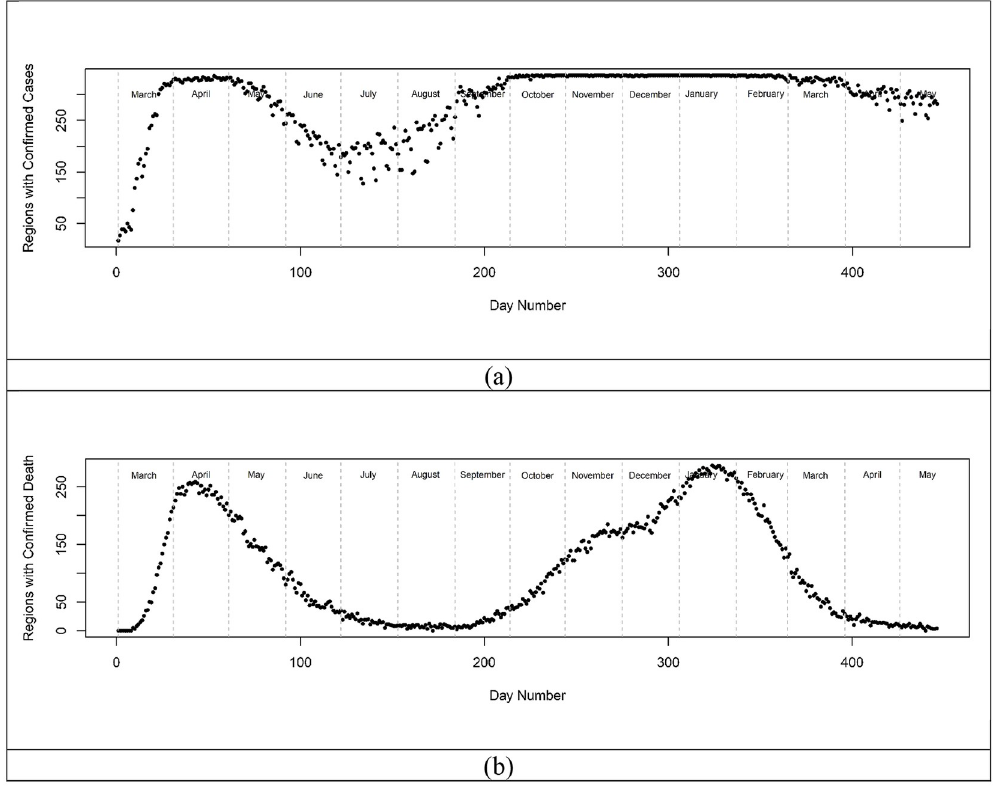
Fig 1. Time series indicating the number of LTLAs returning cases (a) or deaths (b) over the period of